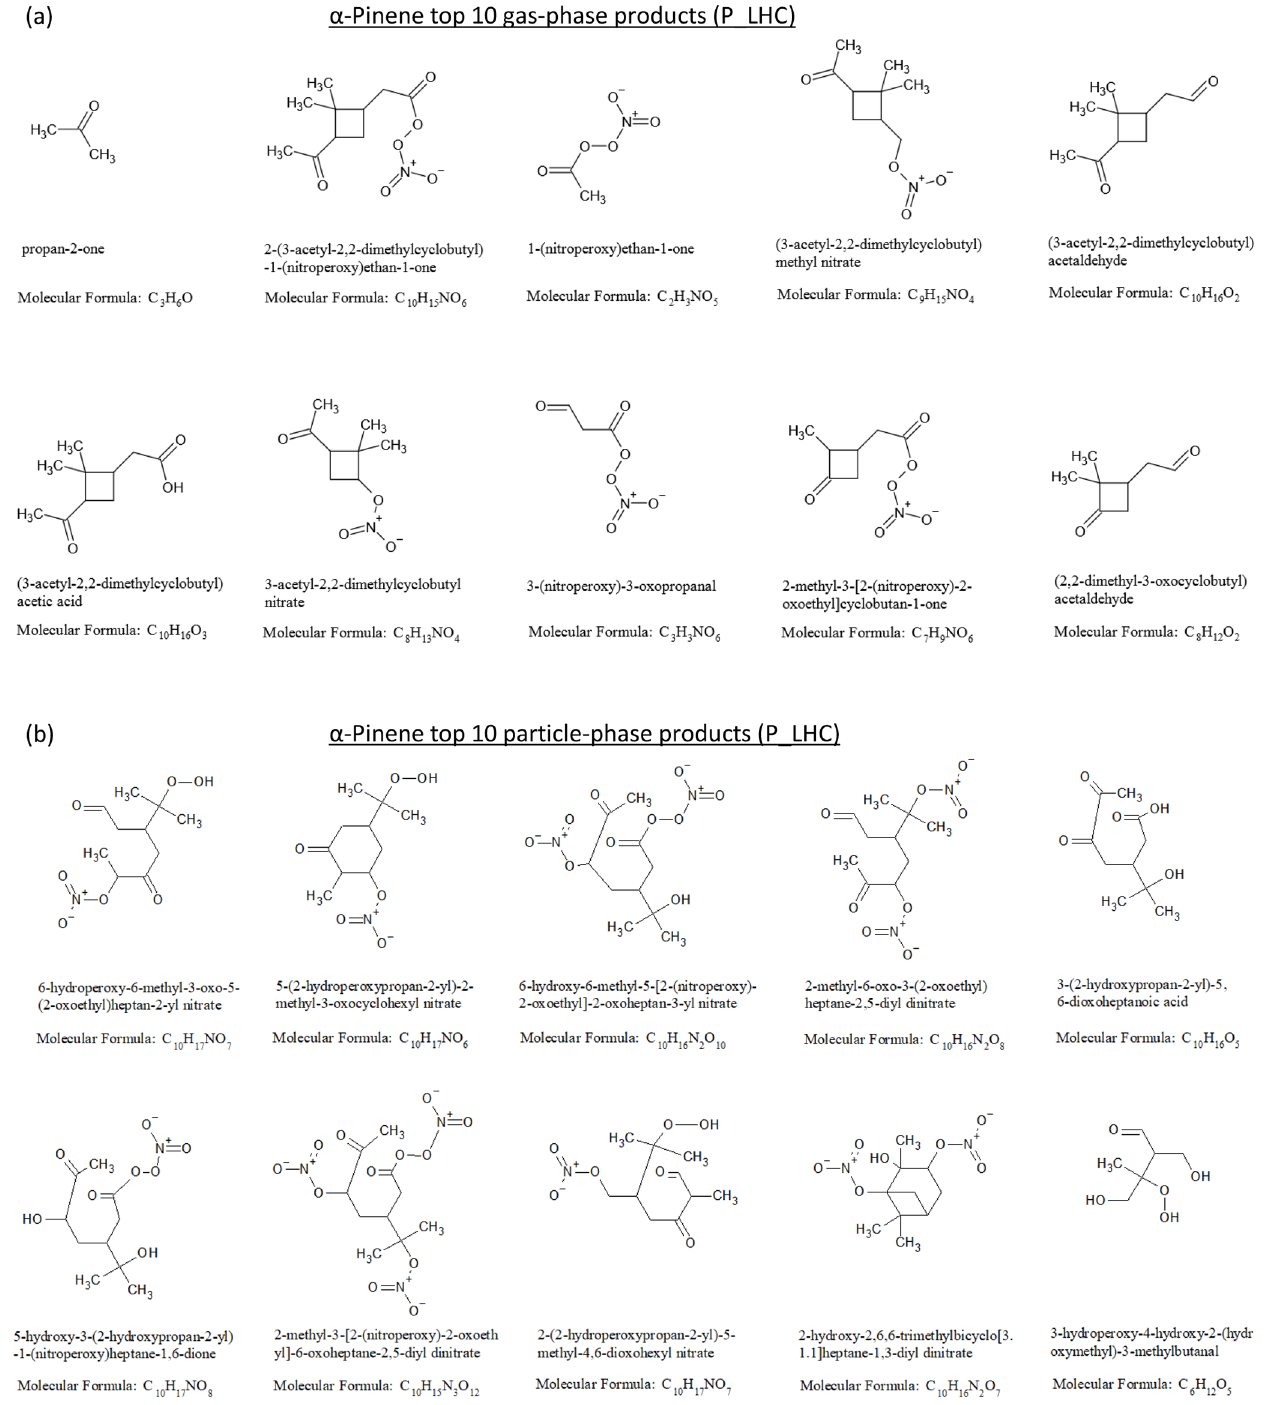
Figure 5. (a) Top 10 gas-phase products and (b) top 10 particle-phase products from α -pinene photooxidation at the end of the low hydro- carbon (P_LHC)